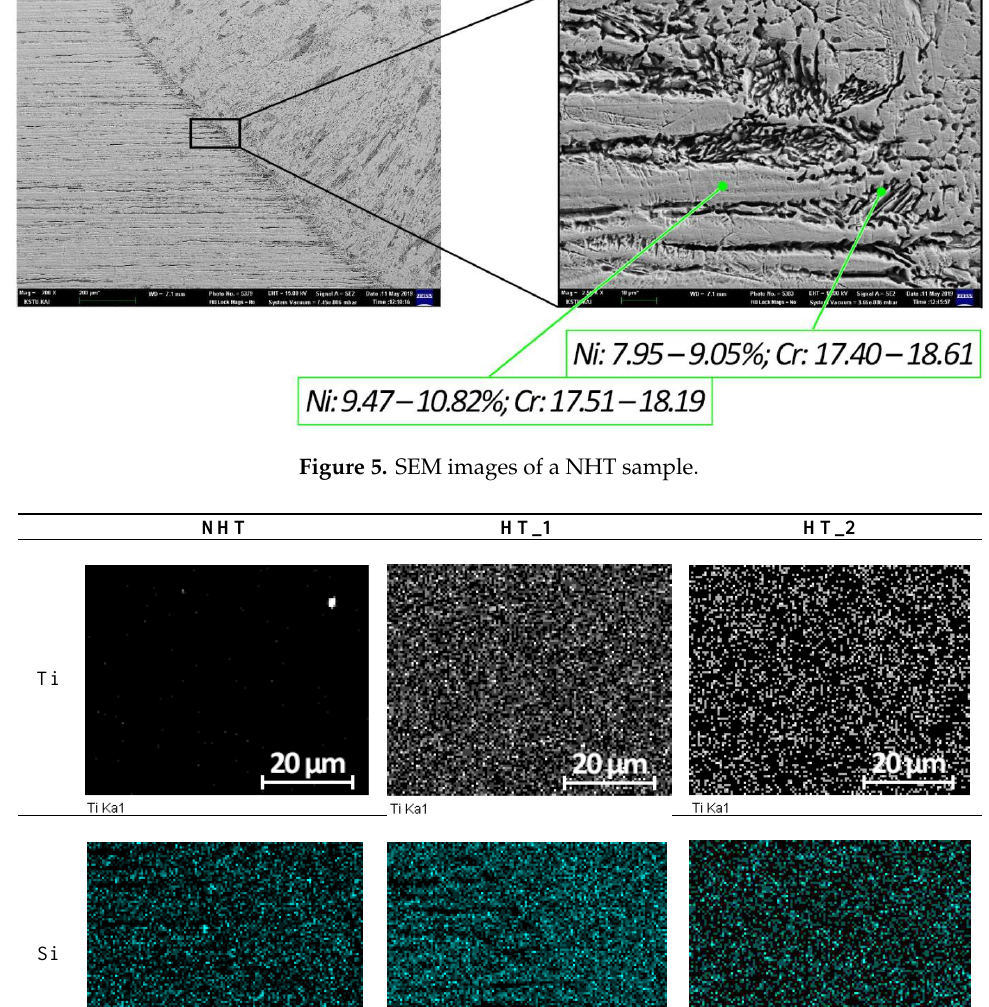
Table 3. Content of chemical elements in different spectra of NHT and HT_1 samples.